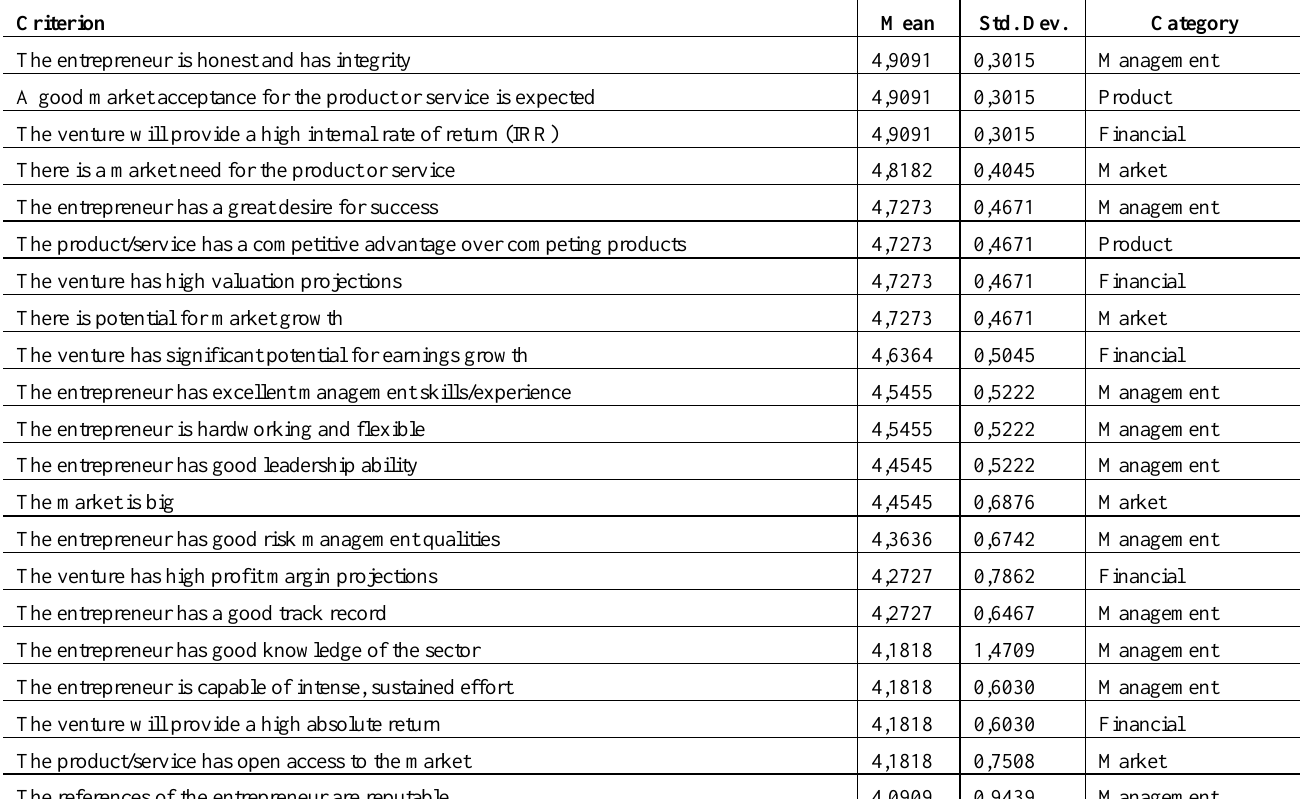
Table 3: Criteria rated as important by participating VCs